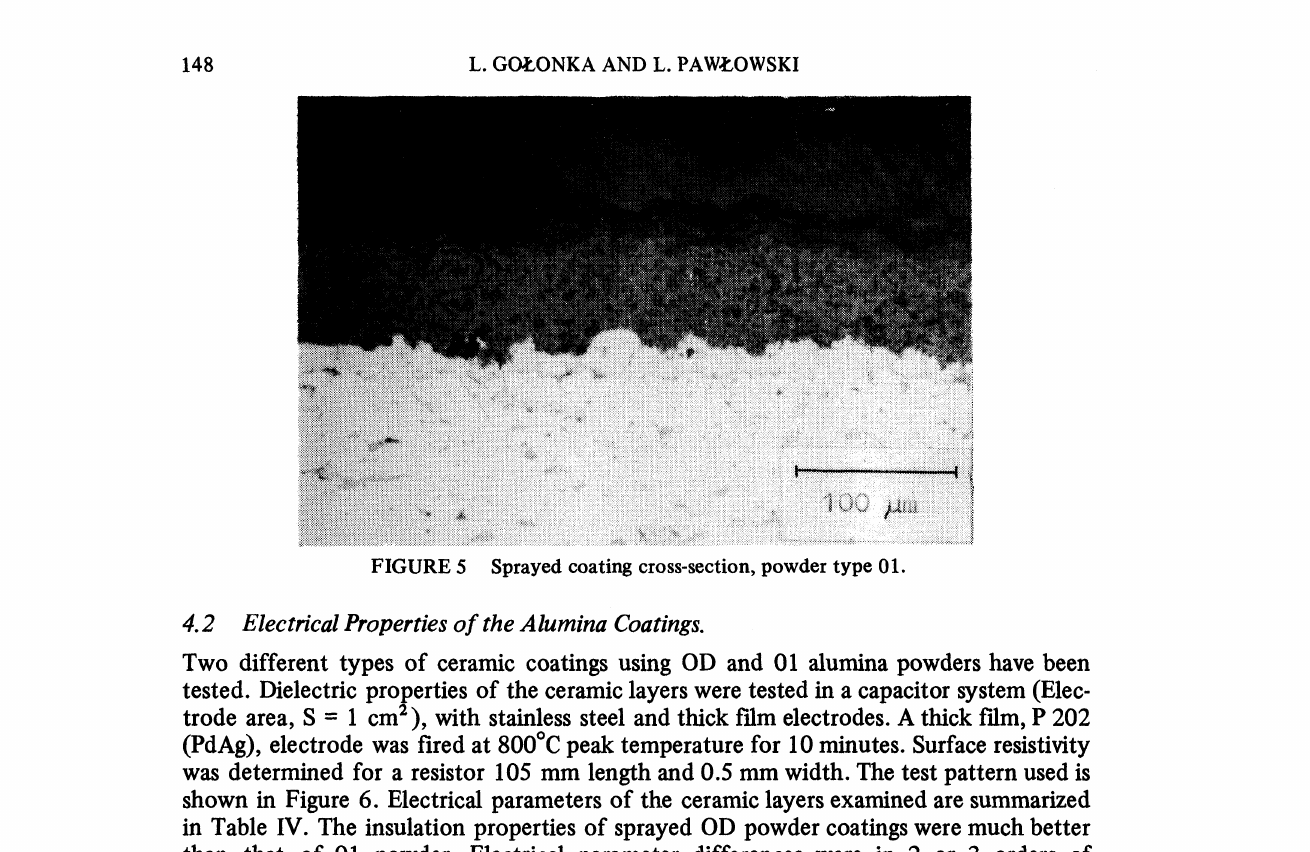
FIGURE 6 Test pattern. TABLE IV Electrical properties of plasma sprayed alumina